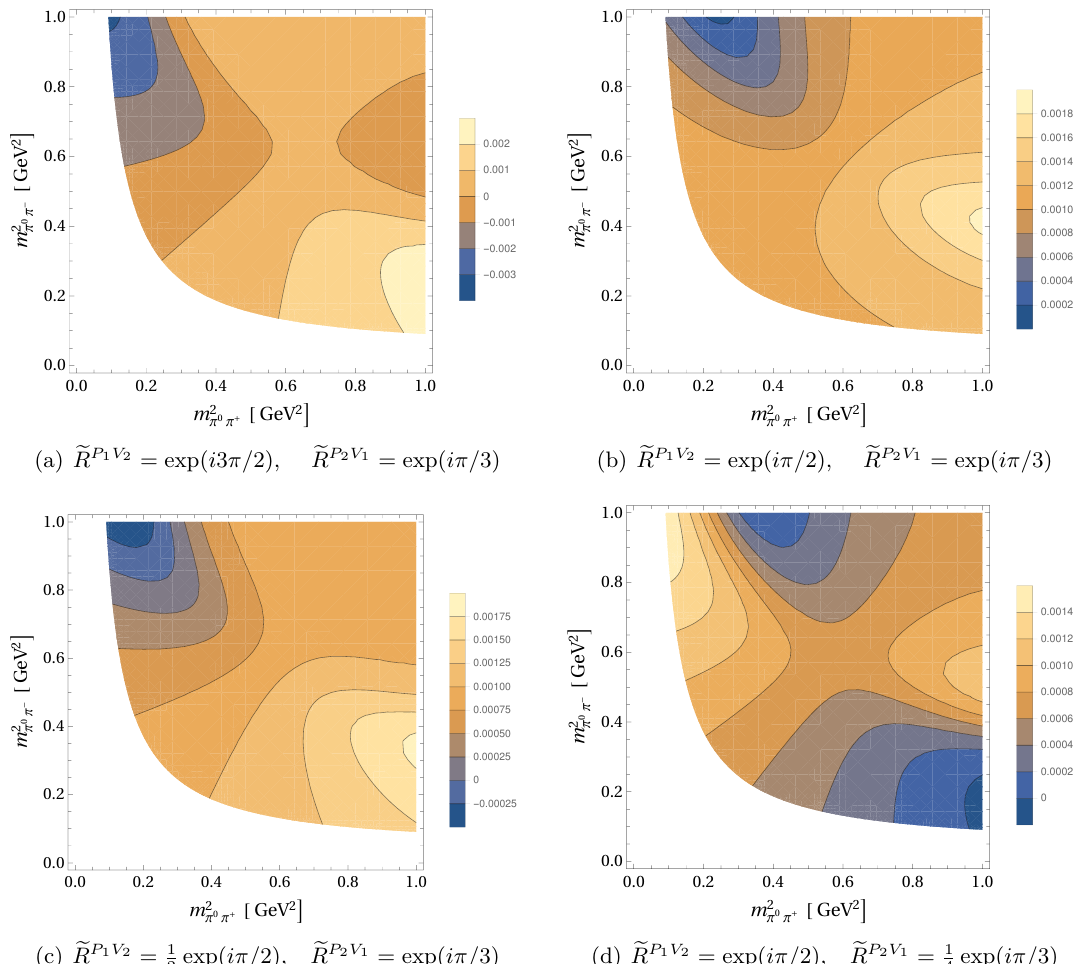
Figure 1 . Local CP asymmetry of D → π + π − π 0 in the region of the overlap of the ρ ± resonances, for different values of e R P 1 V 2 and e R P 2 V 1